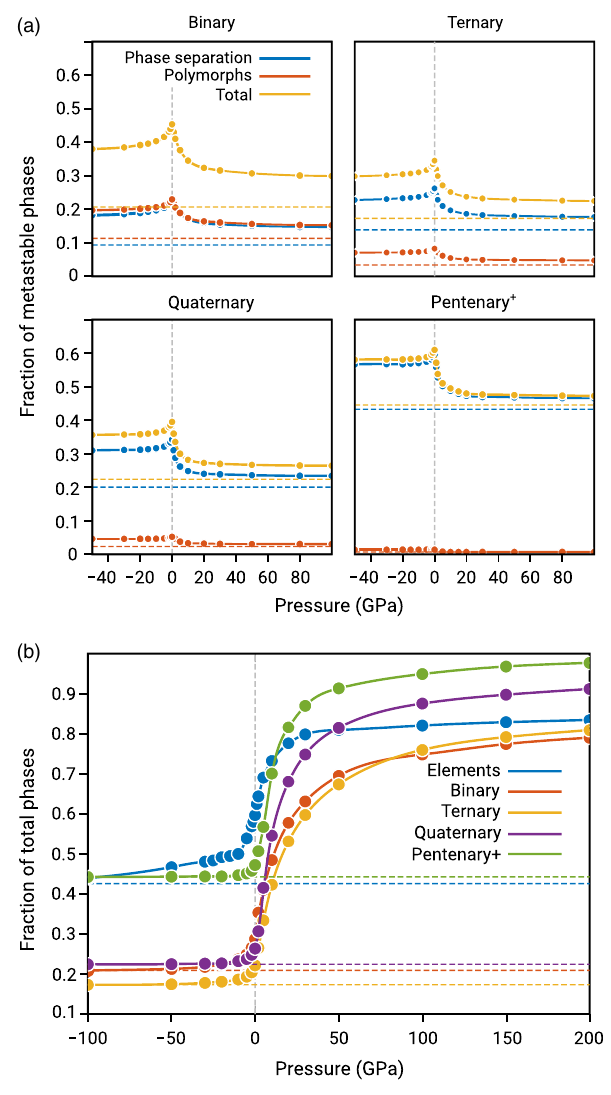
FIG. 6. (a) Fraction of metastable phases that become thermodynamically stable with incremental increase/decrease in pressure, with respect to 0 GPa. The horizontal dashed lines indicate the fraction of metastable phases that do not lie on the N – V – E convex hull at any pressure. (b) Fraction of ambient- metastable phases that cannot be accessed thermodynamically at any pressure larger than pressure p , equivalent to 1- (fraction of phases that can be accessed at some pressure larger than pressure p